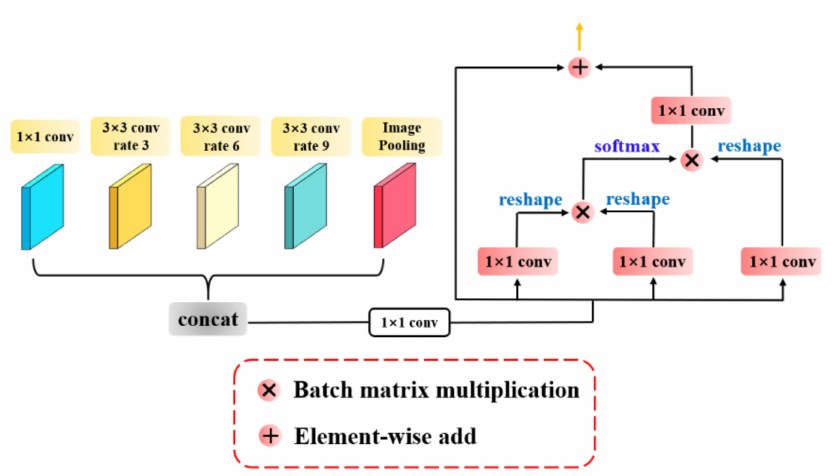
Figure 4. Multi-scale spatial context enhancement